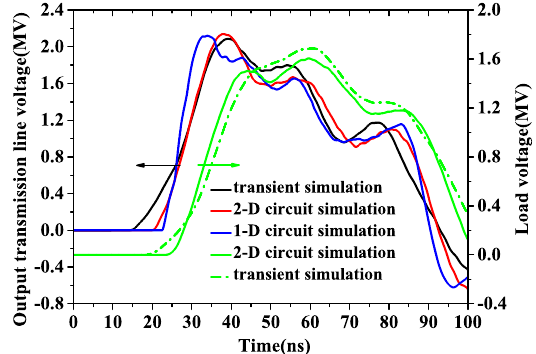
FIG. 8. Output transmission line and dummy load voltage waveforms acquired by 2D circuit simulation and transient electromagnetic simulation. The output transmission line voltage obtained by 1D circuit simulation (blue solid line) is also shown. The black solid line and red solid line represent the output transmission line voltage obtained by transient electromagnetic simulation and 2D circuit simulation, respectively, while the green solid line and green dash-dotted line represent the load voltage achieved by 2D circuit simulation and transient electro- magnetic simulation, respectively. The output transmission line voltage probe is near the ground end. Comparing with 1D circuit simulation the output transmission line voltage waveform given by 2D circuit simulation agree with the result achieved by transient electromagnetic simulation